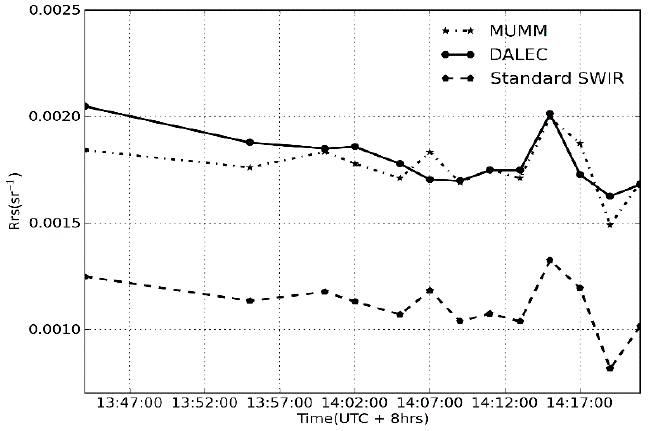
Figure 6. R rs (B1) from the standard atmospheric correction method in SeaDAS SWIR and the MUMM atmospheric correction method in comparison with DALEC measurements for 6 July 2015.